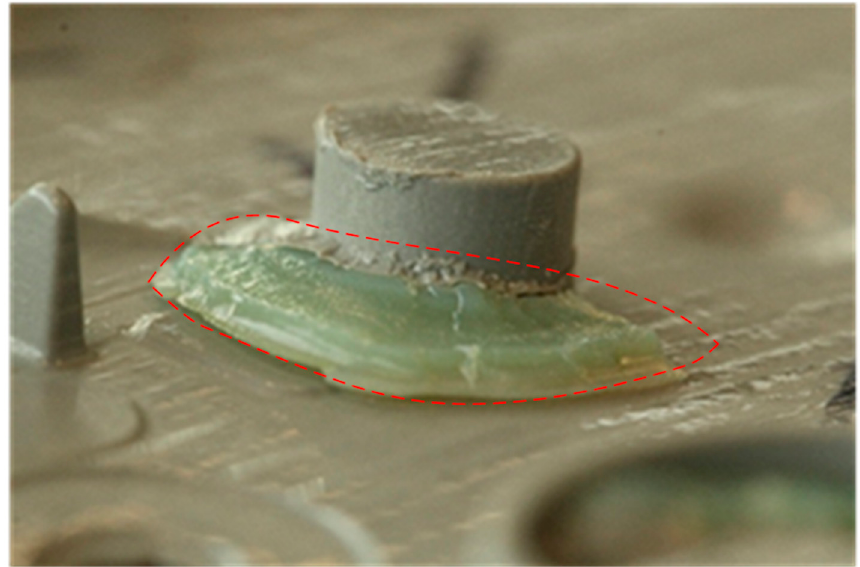
Figure 9. Molded part showing peeled off tool material from the top surface. This occurred during the ejection of the part. (Area highlighted is the tool material pulled out).